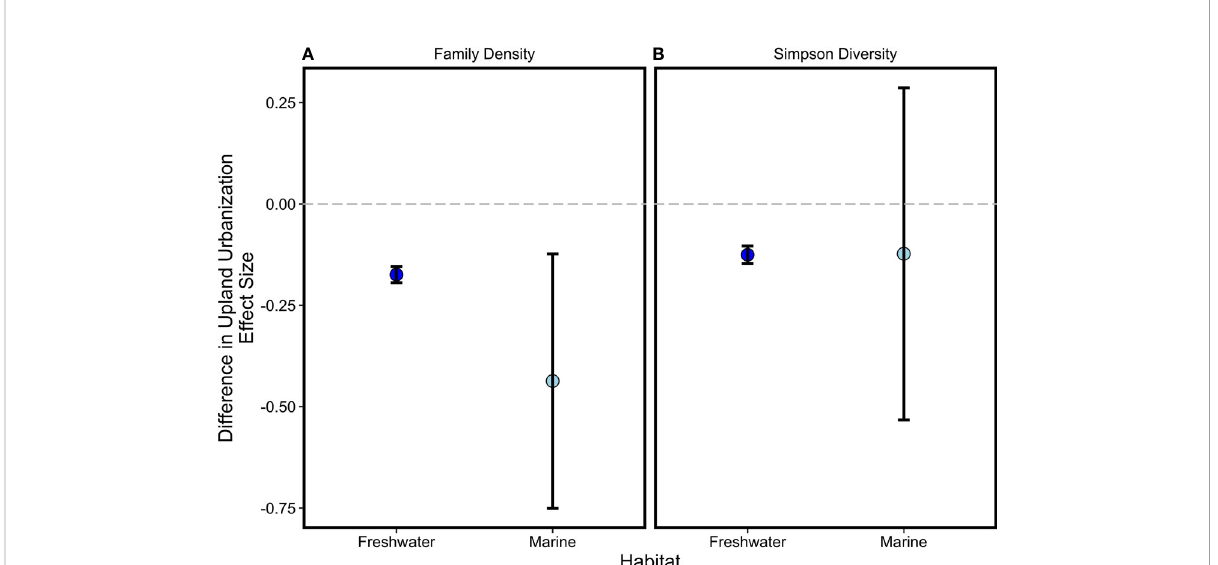
FIGURE 4 Mean effect sizes (with 95% CI) for relationships between biodiversity differences [ (A) family density; (B) Simpson diversity] and differences in the upland urbanization index in freshwater and coastal marine habitats. Effect sizes related to two ecosystem functions (net primary productivity and decomposition) also did not differ between habitat types (not